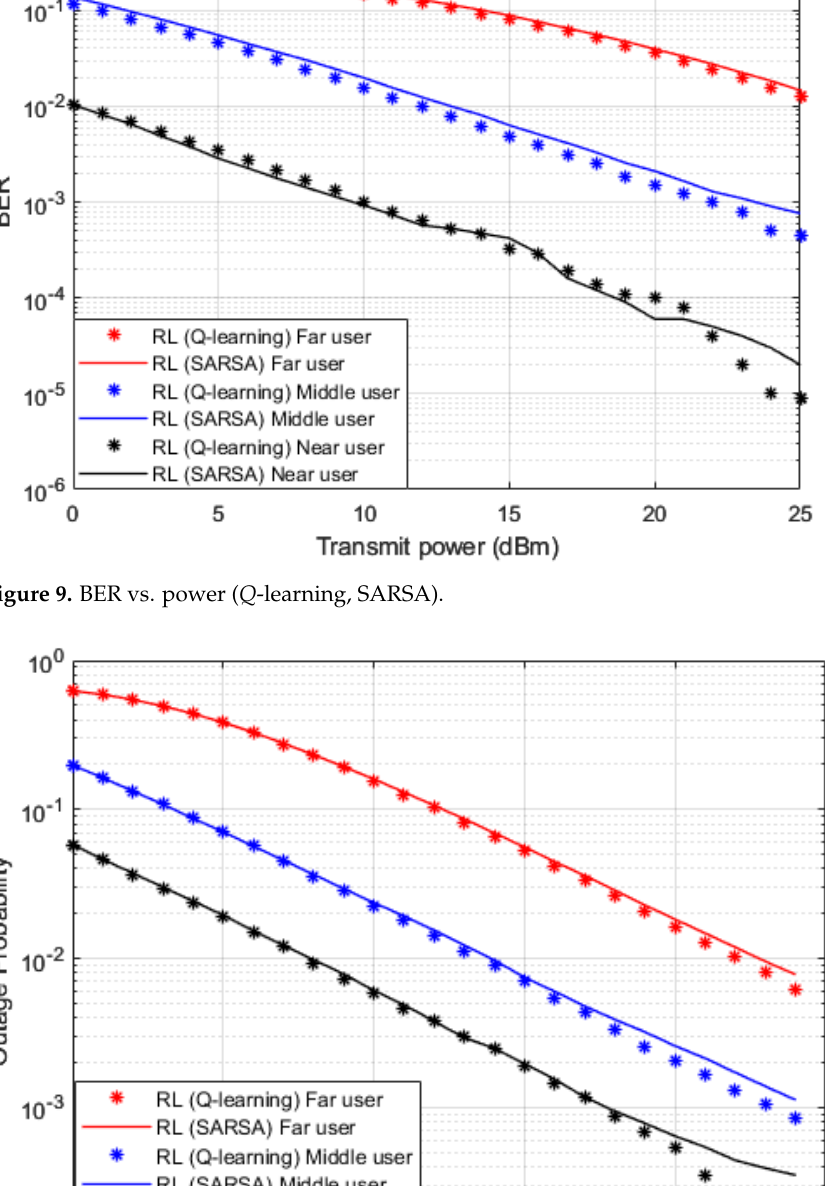
Figure 8. Individual rate vs. power ( Q ‐ learning, Conventional NOMA (MMSE)).